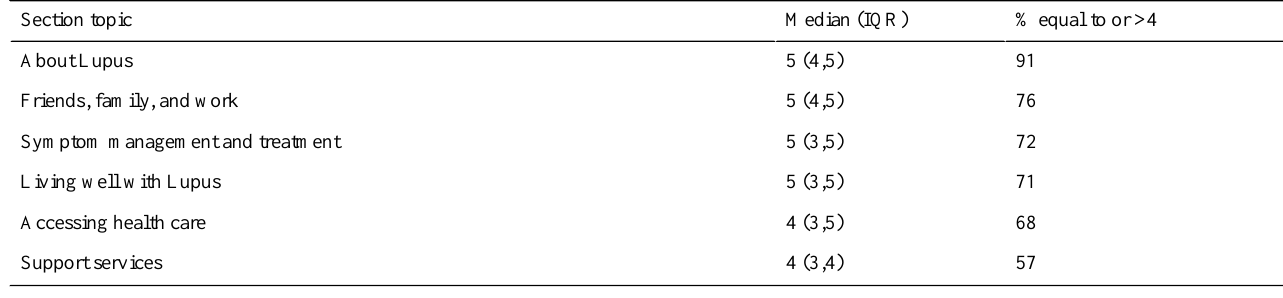
Table 4. Ratings of helpfulness of the LIN content across information topics based on 37 participants (1=not at all helpful; 5=most